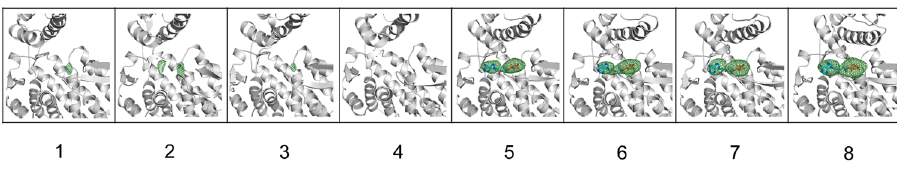
Fig. 3 Difference map analysis of the nucleotide occupancy in each of the eight conformations. Model for each conformation is generated by rigid body fi tting and followed by real space re fi nement. The panels show the nucleotide binding pocket of each conformation. The density (in green mesh) represents difference density attributable to nucleotide in the binding pocket. A model of ADP is shown here to illustrate the orientation of the nucleotide in the binding pocket. The difference map is displayed at + 4 σ